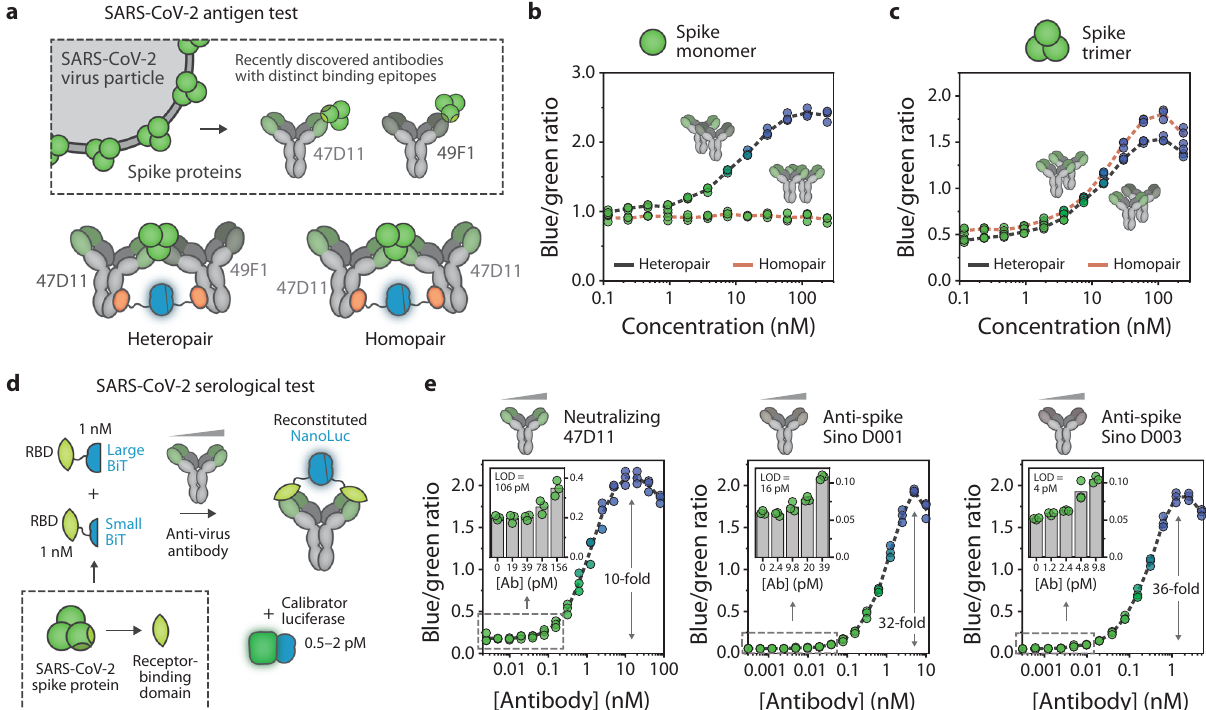
Fig. 5 The RAPPID platform enables the detection of both the SARS-CoV-2 spike glycoprotein and anti-RBD antibodies. a Schematic overview of RAPPID sensors for the detection of trimeric SARS-CoV-2 spike proteins. Recently discovered antibodies 53,64 targeting distinct binding epitopes of the immunogenic spike protein were used to generate sensors in either a heteropair or homopair setup. b , c RAPPID response curves in response to increasing concentrations of monomeric spike protein ( b ) and native trimeric spike protein ( c ) using both the heteropair (gray) and homopair (red) con fi guration. Photoconjugations were performed as described in Supplementary Fig. 27, and conjugation mixtures were used without further puri fi cation. A 200-fold excess of cetuximab was added to suppress background luminescence. Experiments were prepared with 1 nM anti-spike (47D11) conjugated to Gx-LB and 10 nM anti-spike (49F1 for heteropair, 47D11 for homopair) conjugated to Gx-SB. Subsequently, experiments were performed in buffer (PBS (pH 7.4), 0.1% (w/v) BSA) and incubated for 1 h at room temperature before addition of NanoLuc substrate and recording of the emission spectra. The blue/green ratio was calculated by dividing bioluminescent emission at 458 nm by emission at 518 nm. d Schematic overview of RAPPID sensors for direct monitoring of anti-virus antibodies against the receptor-binding domain (RBD) of SARS-CoV-2 spike protein. LB and SB were expressed as fusion proteins with the RBD, enabling detection of all RBD-targeting antibodies. e Ratiometric sensor response curves for neutralizing antibody 47D11 (left) 53 , and commercially available anti-spike D001 (center) and D003 (right) 64 . Insets show sensor response at low target concentrations, which allowed calculation of the limit of detection, as indicated in the graphs. Experiments were performed with sensor and calibrator concentrations indicated in ( d ), prepared in buffer (PBS (pH 7.4), 0.1% (w/v) BSA), and incubated for 1 h at room temperature before addition of NanoLuc substrate. The fold increase is indicated in each graph. Individual data points are represented as circles, while dashed lines connect mean values. All experiments were performed in technical triplicate, with n = 3 independent preparations of the analyte. Bars in histograms represent mean values. Source data are provided as a Source Data fi